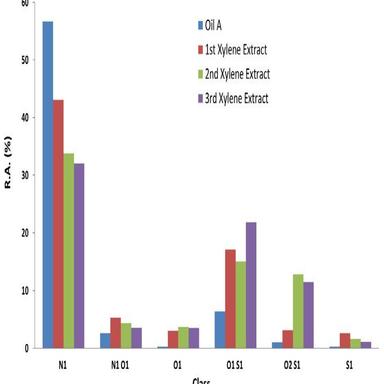
Comparison of Xylene extracts with oil A in (+)ESI.